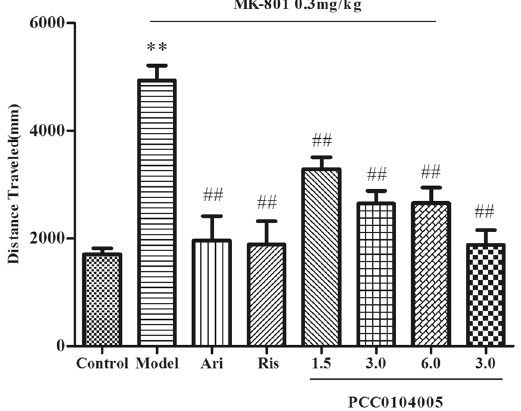
Figure 2. The effect of PCC0104005 on MK-801-induced hyperlocomotion in rats. Rats were administered an oral dose of vehicle alone (0.5% methylcellulose, 1 ml/kg), PCC0104005 (1.5, 3.0, or 6.0 mg/kg), aripiprazole (1.5 mg/kg) or risperidone (0.2 mg/kg) 1 h before test. Then, all animals were intraperitoneally injected with 0.9% saline or MK-801(0.3 mg/kg) 10 minutes before test. Locomotor activity was recorded for 10–20 minutes after the intraperitoneal injection. Results are presented as mean ± S.E.M. (n = 8). * P < 0.05, ** P < 0.01 model group vs. the control group, # P < 0.05, ## P < 0.01 drug delivery groups vs. the model group.